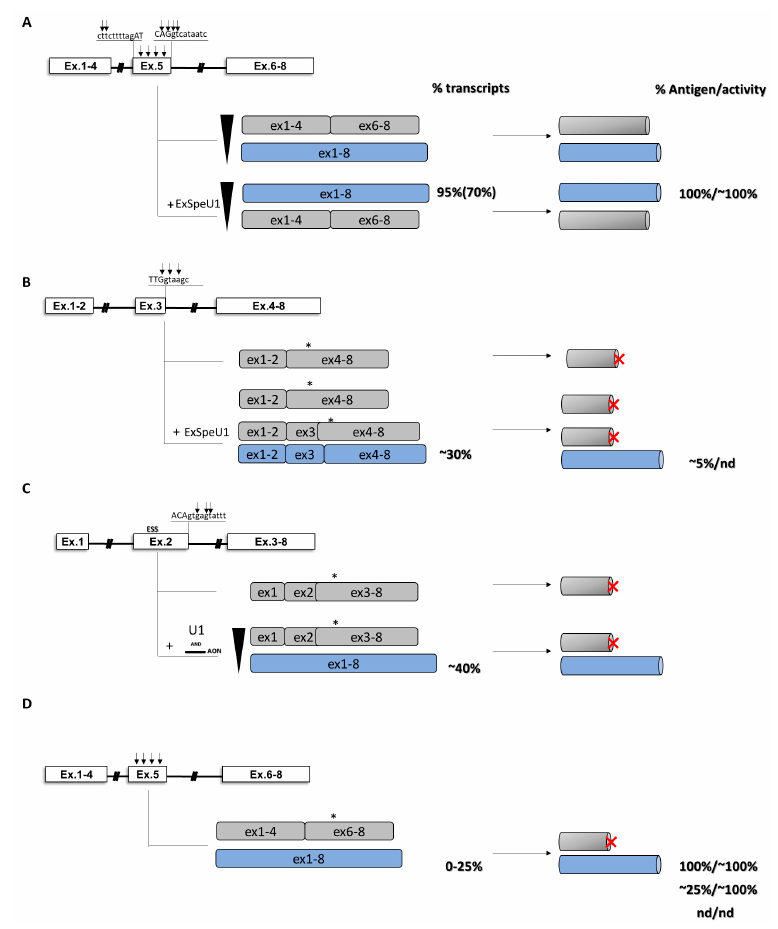
Figure 6. U1-mediated rescue in hemophilia B. Hemophilia B models caused by multiple nucleotide changes at the 3’ss (exon 5, A ), at the 5’ss (exons 2, 3 and 5, B , C and D ) or within exon (exon 5, panel D ) of various exons of the F9 gene. Schematic representation of the genomic context ( left panel), splicing transcripts ( middle panel) and protein isoforms ( right panel) is reported. Sequences of the splice sites and position of mutations (black arrows) are indicated. Frameshift of the coding sequence and premature stop codons are reported by asterisks and red X letter, respectively. Percentages of transcripts, antigen and relative coagulation activity are reported. Values in rounded brackets indicate experiments in mouse model of the disease.